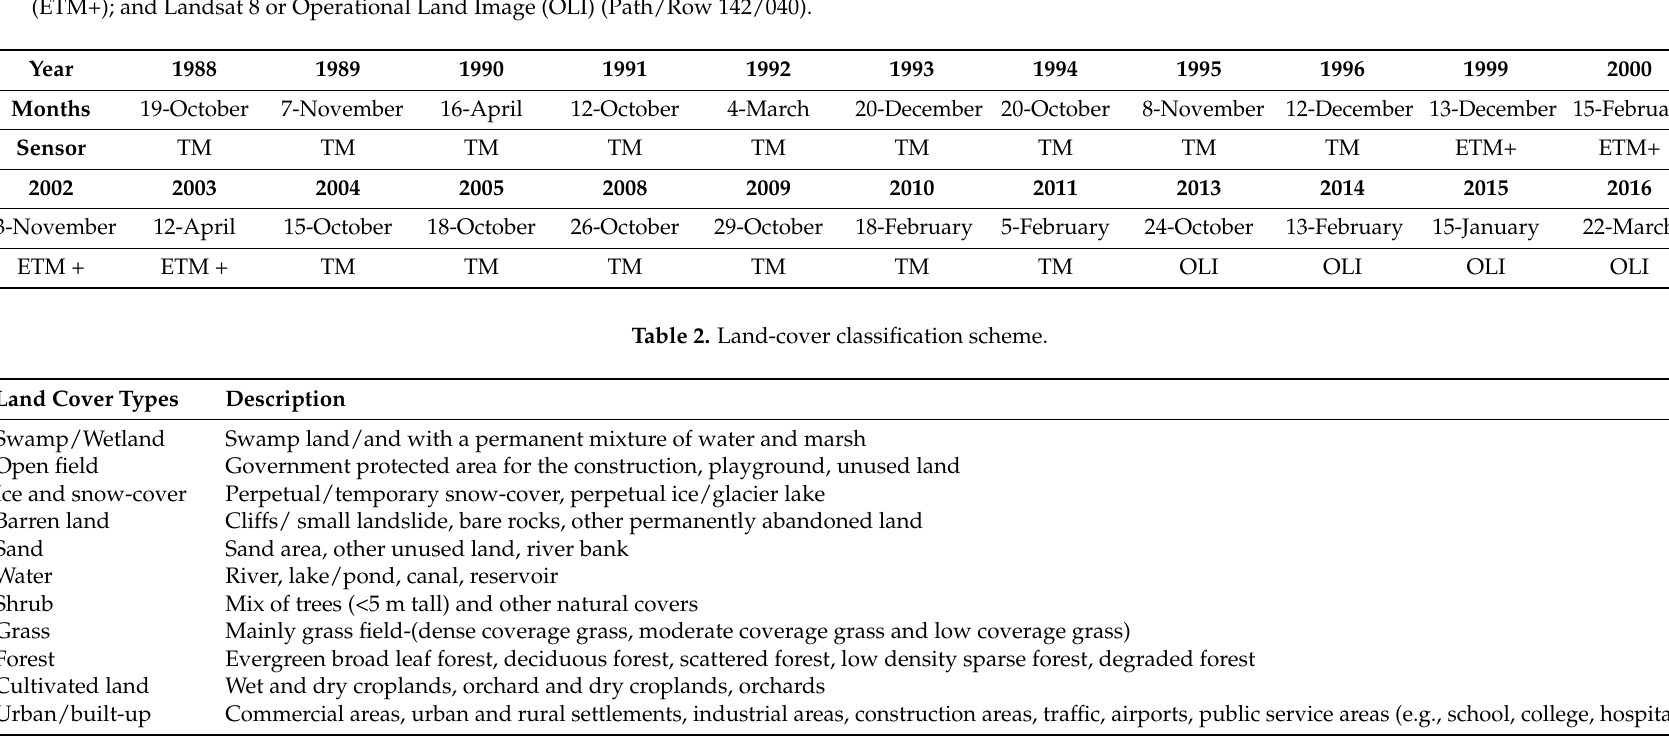
Table 1. Satellite data used in the study: Landsat Time series 5, 7 and 8 images: Landsat 5 or Thematic Mapper (TM); Landsat 7 or Enhanced Thematic Mapper Plus (ETM+); and Landsat 8 or Operational Land Image (OLI) (Path/Row 142/040).